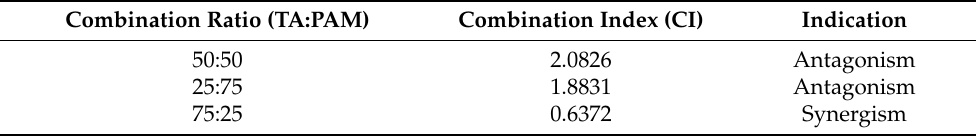
Table 2. Combination index (CI) value for the combination of tannic acid (TA) and pamidronate (PAM).